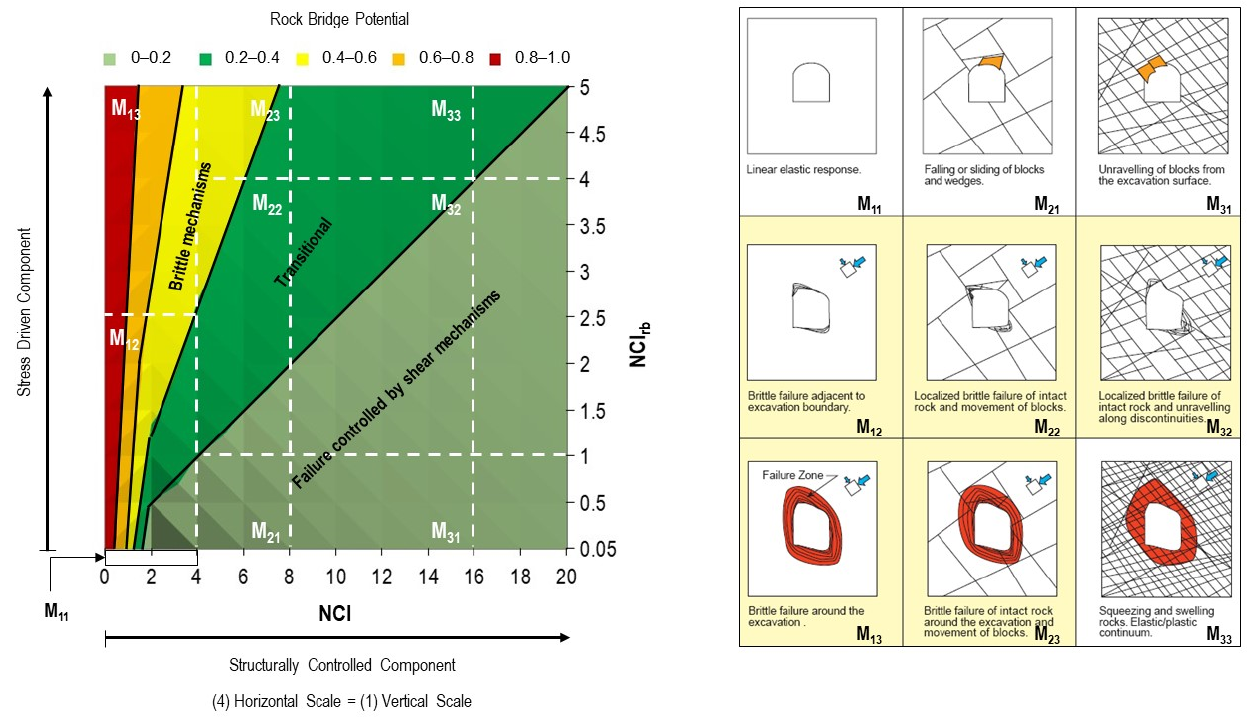
Figure 9. Relationship between rock bridge potential ( left ) and the rock mass behaviour matrix by [8] ( right ).